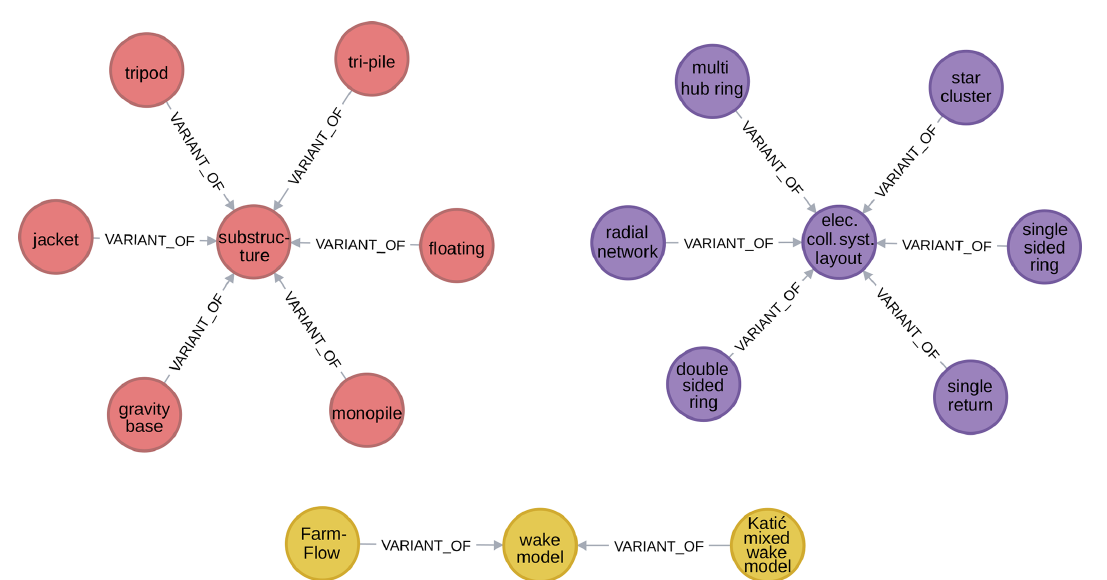
Figure 6. Excerpts from WESgraph of the subgraph defined by the VARIANT OF